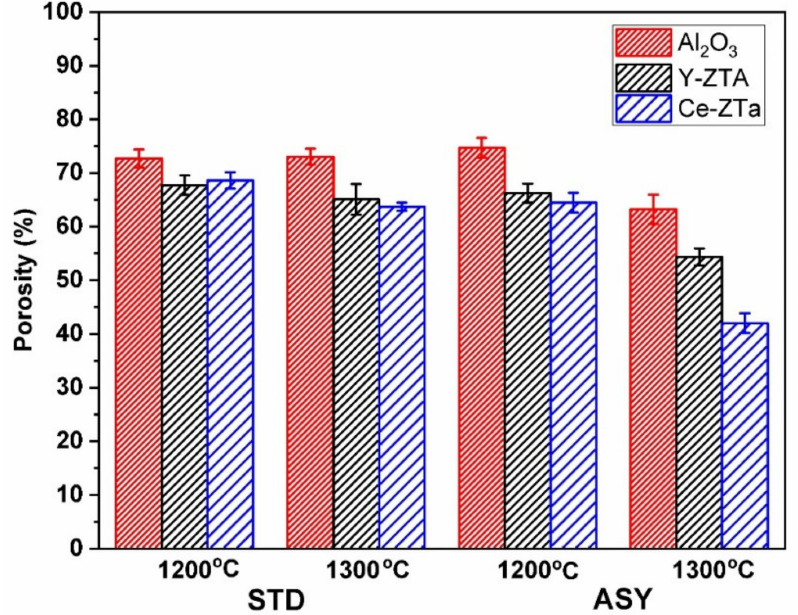
Figure 4. Apparent porosity of the ceramic bodies manufactured at different temperatures in ASY and STD graphite configurations. Red, black, and blue bars represent the samples of Al 2 O 3 , Y-ZTA, and Ce-ZTA,